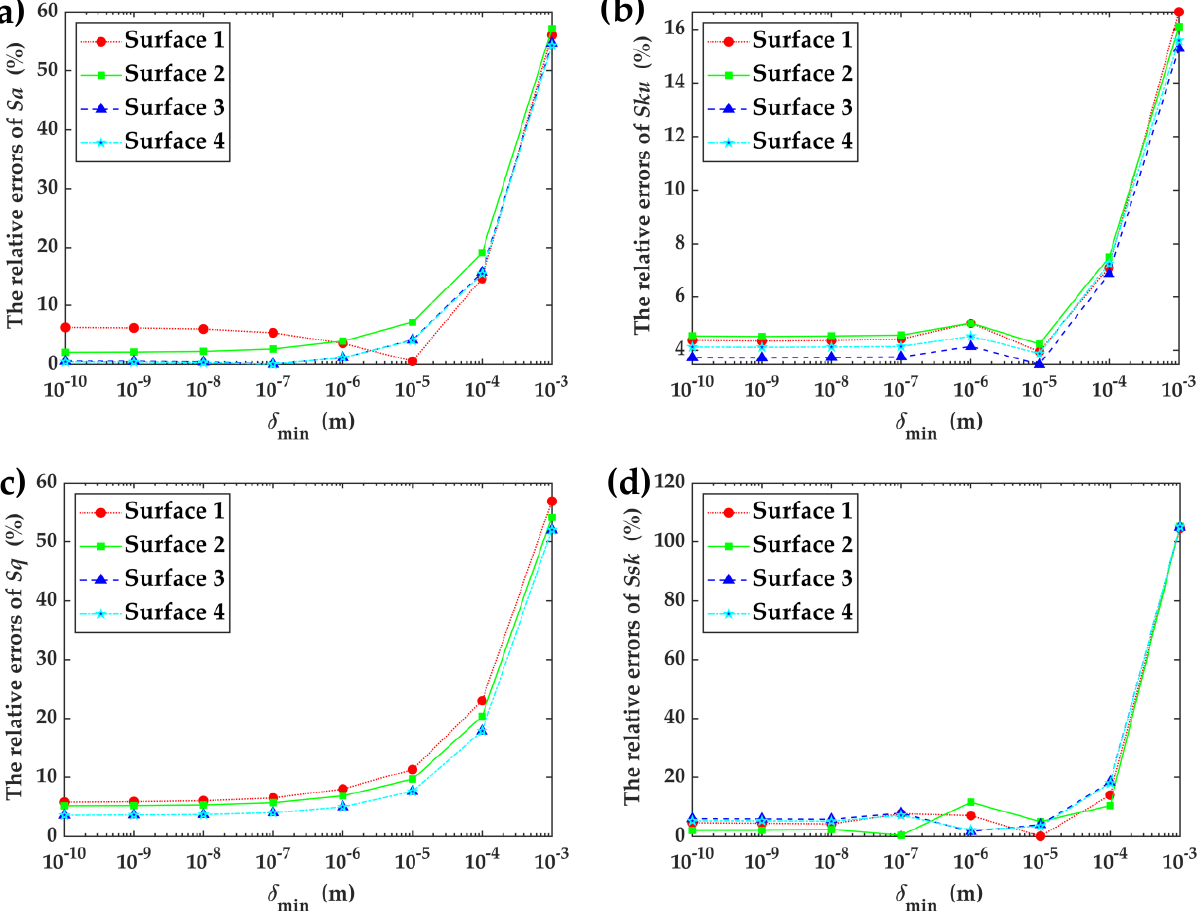
Figure 7. The relative errors of roughness parameters under different δ min : ( a ) Sa ; ( b ) Sq ; ( c ) Ssk ; ( d ) Sku .